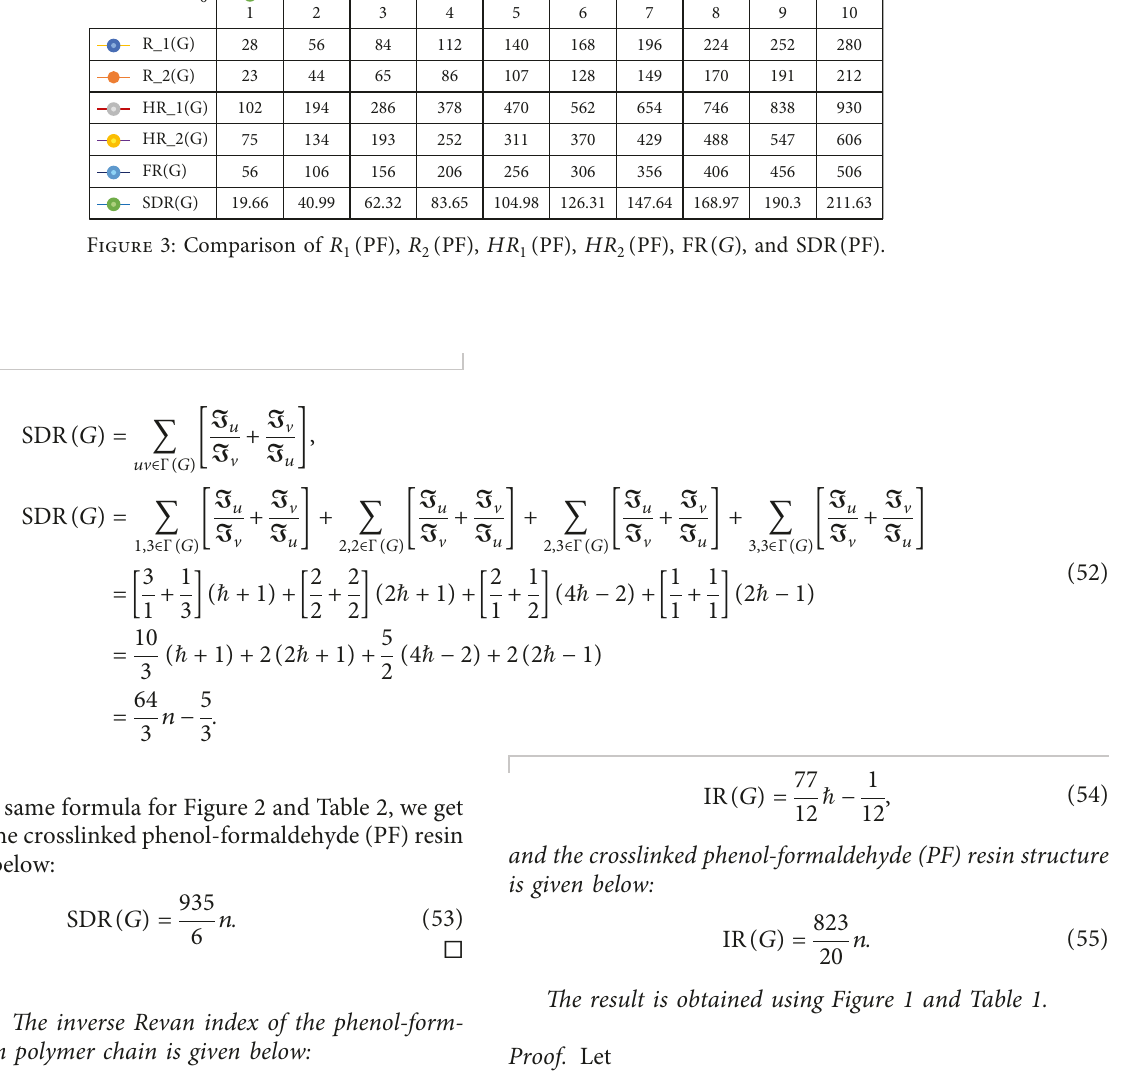
Figure 3: Comparison of R